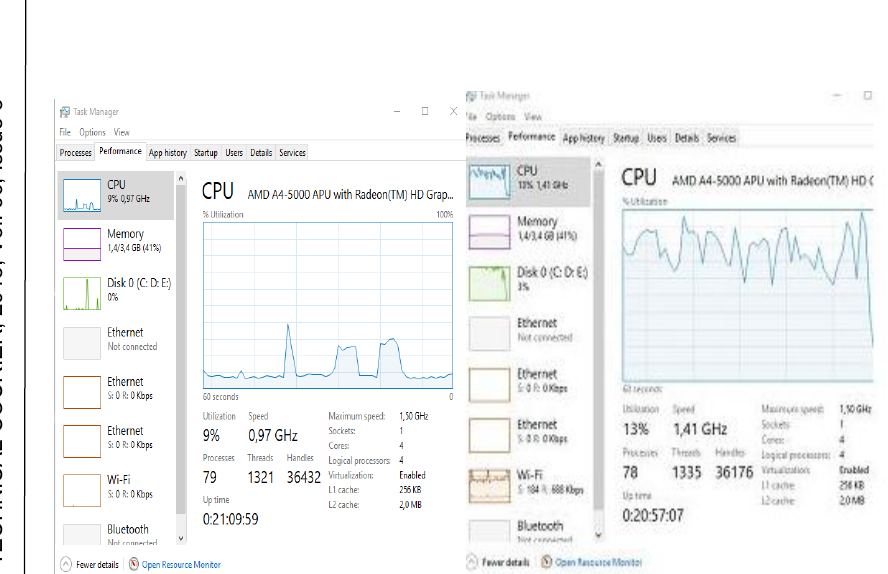
Figure 8 – CPU utilization before and during the attack Рис . 8 – Загруженность процессора до и после атаки